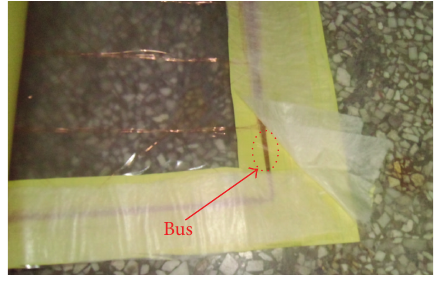
Figure 7: Bus of smart film.